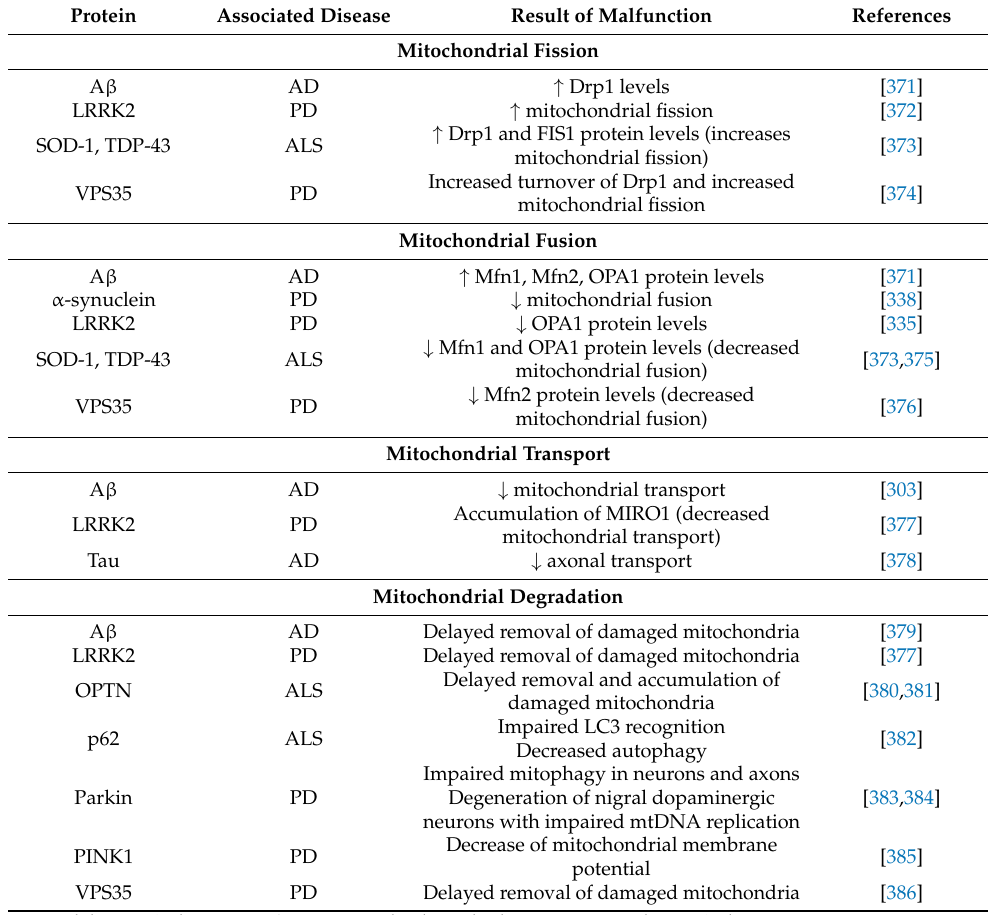
Table 2 summarizes the abnormal proteins associated with the three neurodegenerative diseases discussed and their deleterious actions on mitochondrial function. Table 2. Abnormal proteins associated with impaired mitochondrial function in the three most frequent neurodegenerative diseases (adapted form Paß et al. [72]). ↑ = increases; ↓ = decreases. Protein Associated